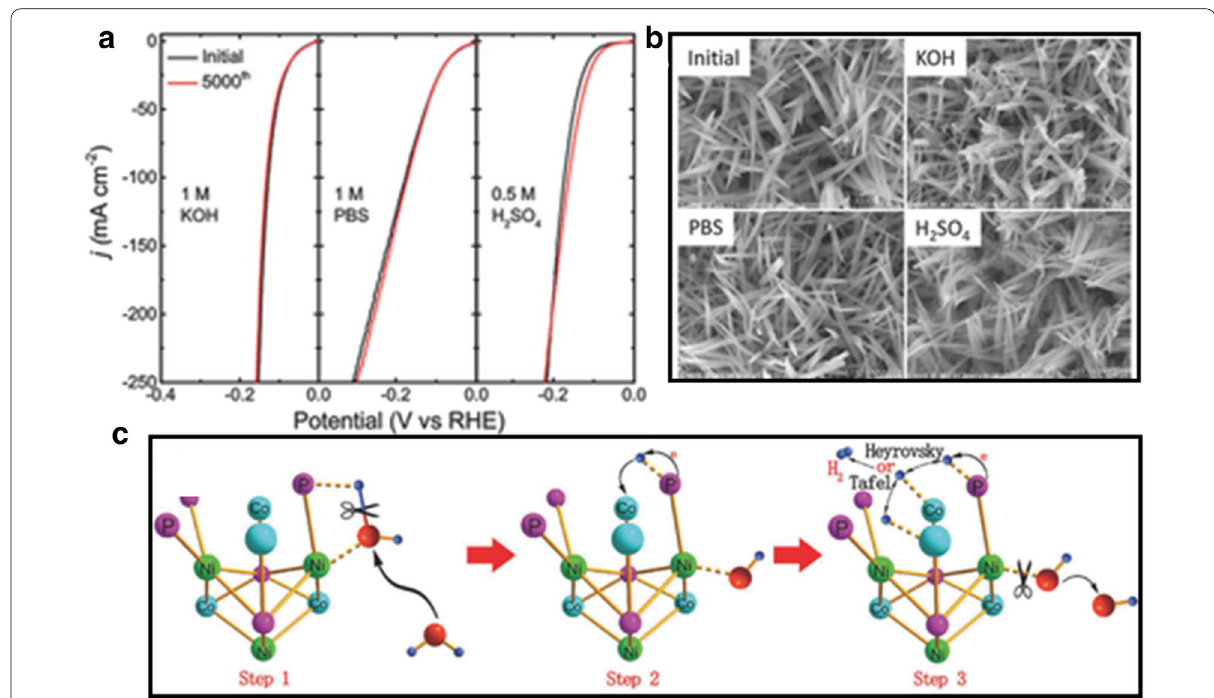
Fig. 7 NiCo 2 P X catalyst: a HER performance in 1 M KOH and PBS and 0.5 M H 2 SO 4 , b SEM images before and after HER long‑term stability test in different media, c schematic illustration of water dissociation over NiCo 2 P X in alkaline solution (Figure reprinted with permission from Ref.